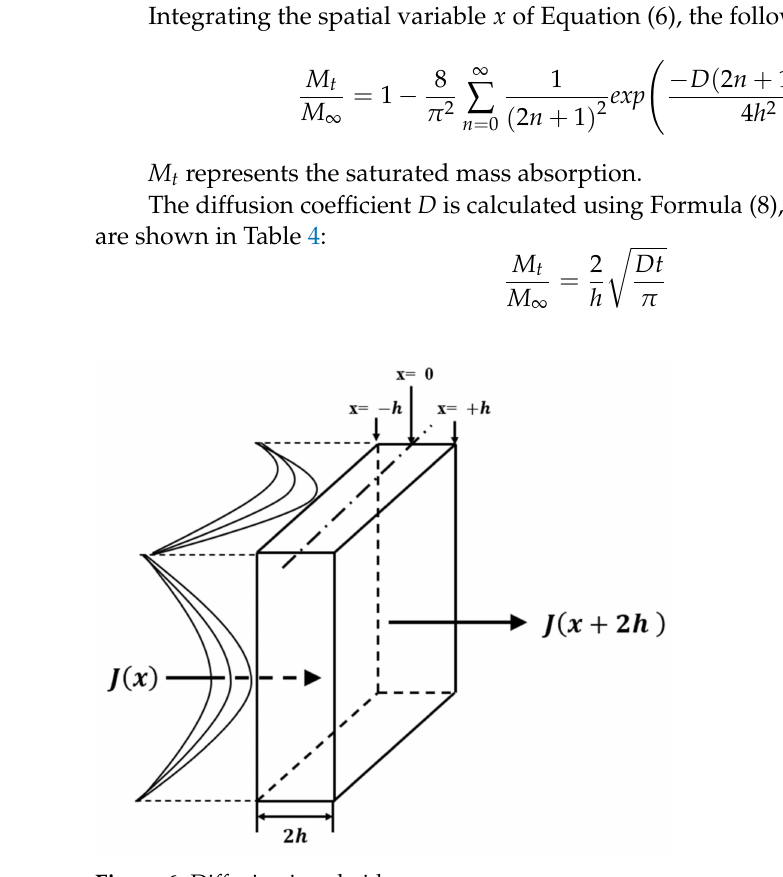
Figure 6. Diffusion in cuboid space. Table 4. Moisture uptake of three different